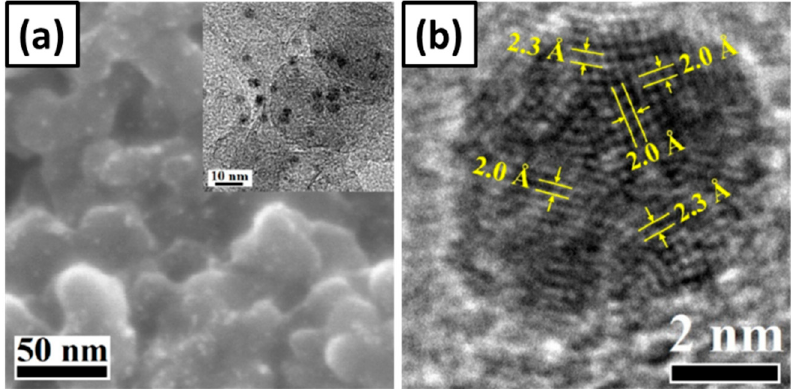
Figure 10. ( a ) SEM micrograph of the PtAu (1:1)/C modified electrode surface (Inserted figure at the upper-right corner: TEM image of the PtAu (1:1) alloy nanoparticle.) and ( b ) corresponding high-resolution transmission electron microscopy (HRTEM). (Reproduced with permission from